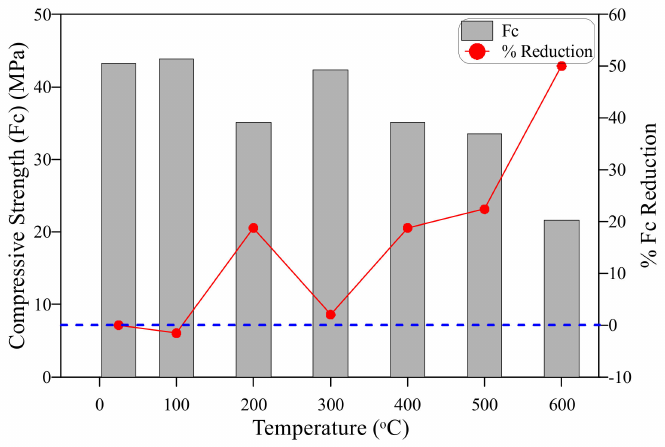
Figure 6. Compressive strength and its percentage reduction at different